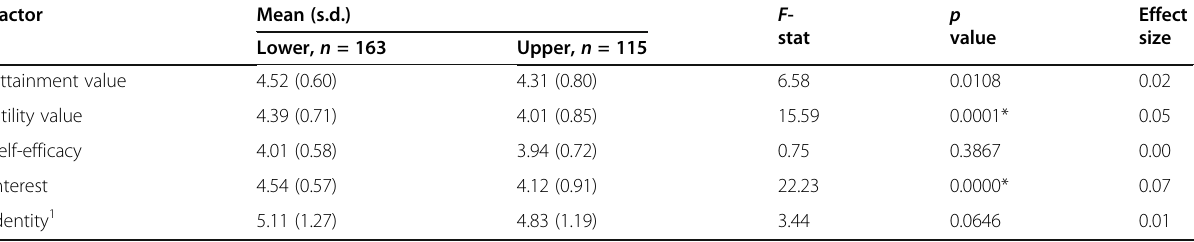
Table 2 One- way ANOVAs by student division, n = 278 Factor